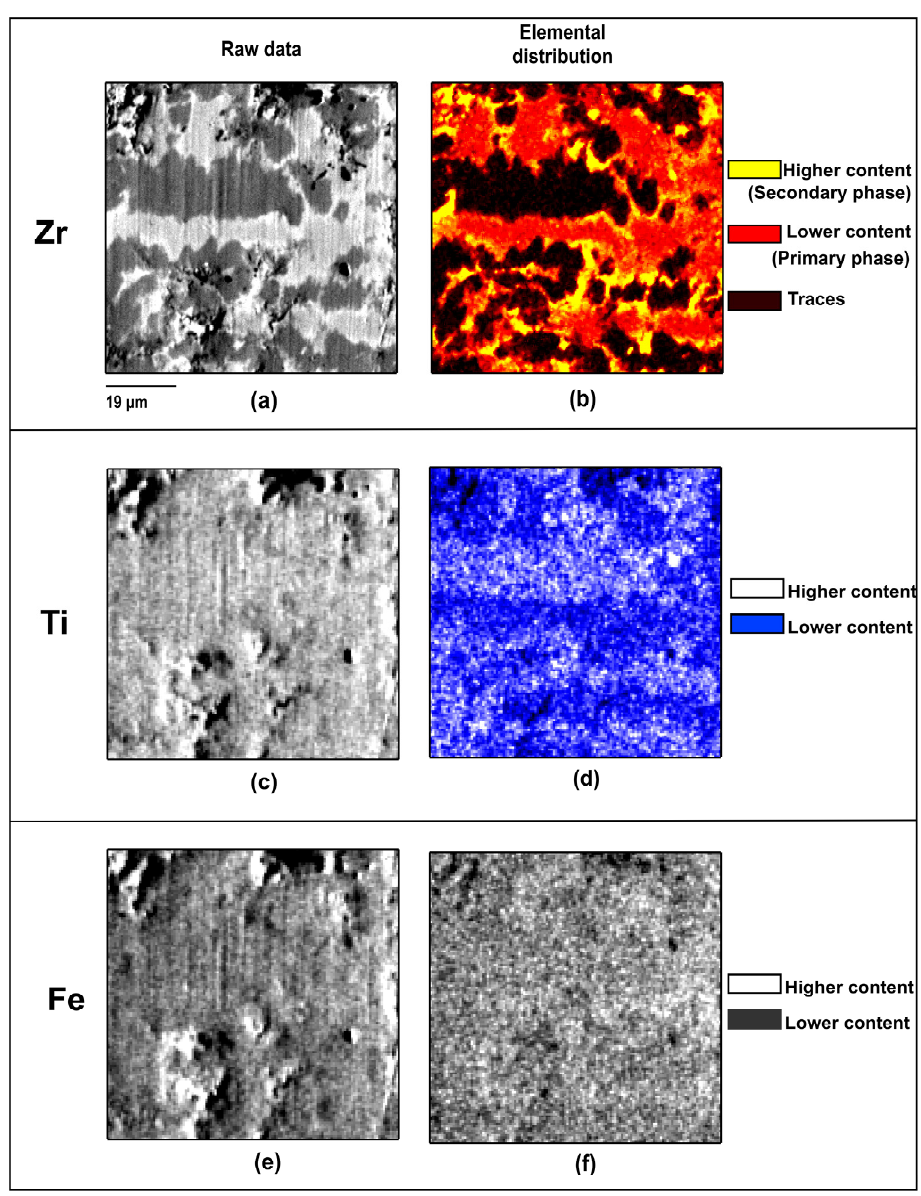
Figure 2. Element distribution in as-cast TiFe + 4 wt.% Zr. Zr ( a , b ), Ti ( c , d ), Fe ( e , f ). Raw data: ( a , c , e ), Elemental distribution ( b , d , f ).